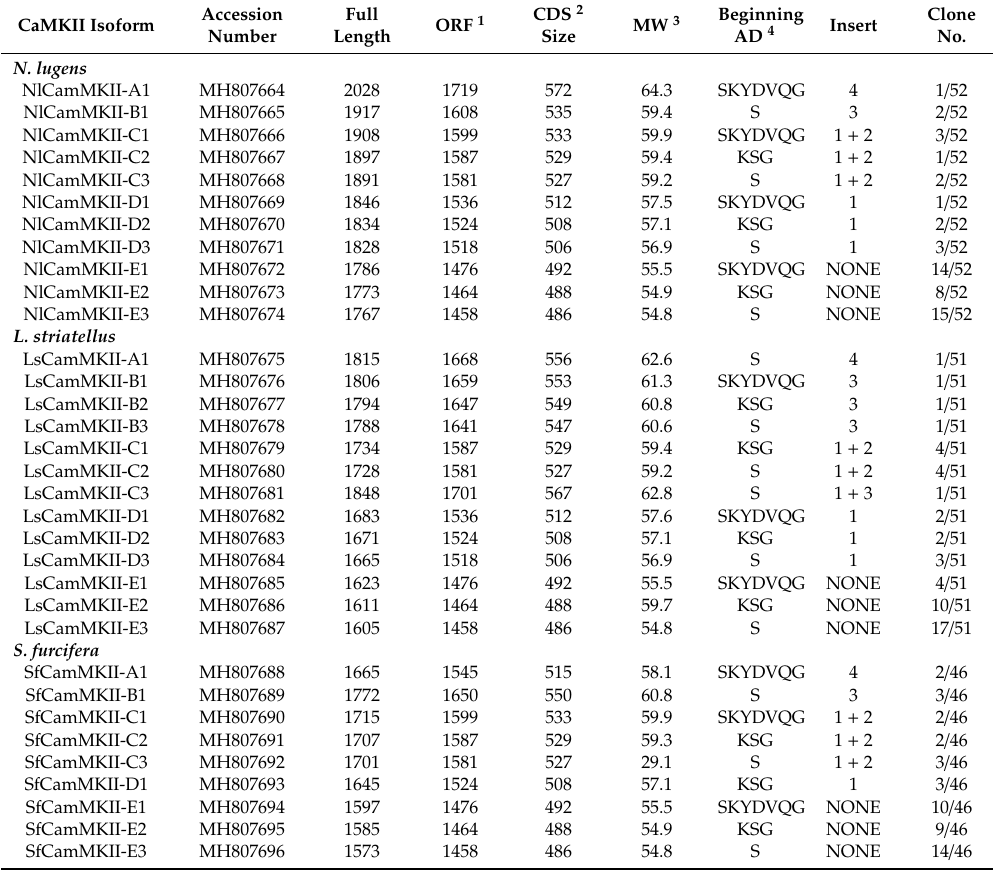
Table 1. Characteristics of CaMKII isoforms from N. lugens , L. striatellus , and S. furcifera. CaMKII